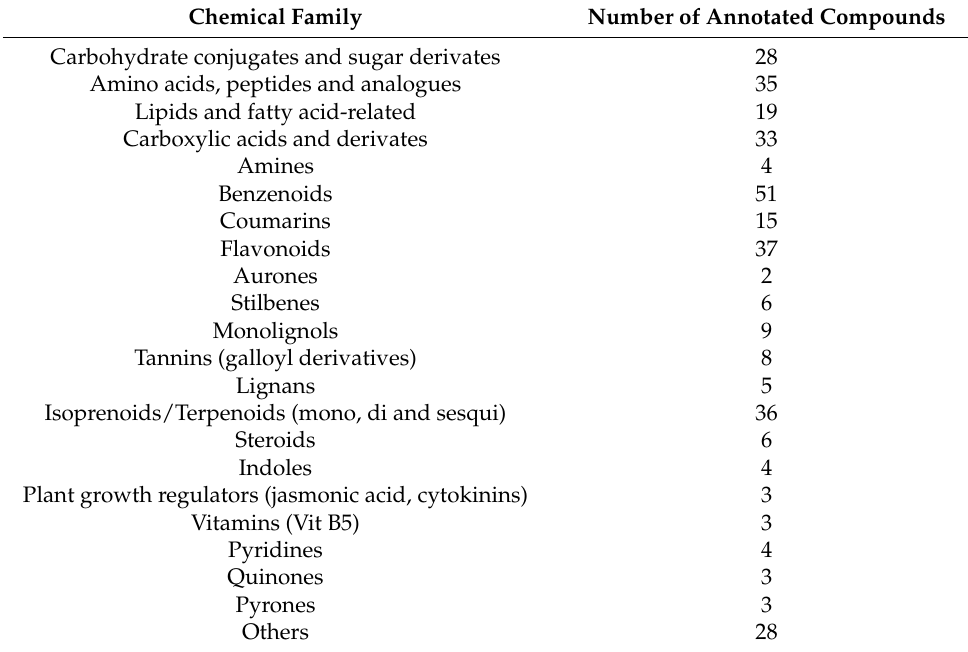
Isoprenoids/Terpenoids (mono, di and